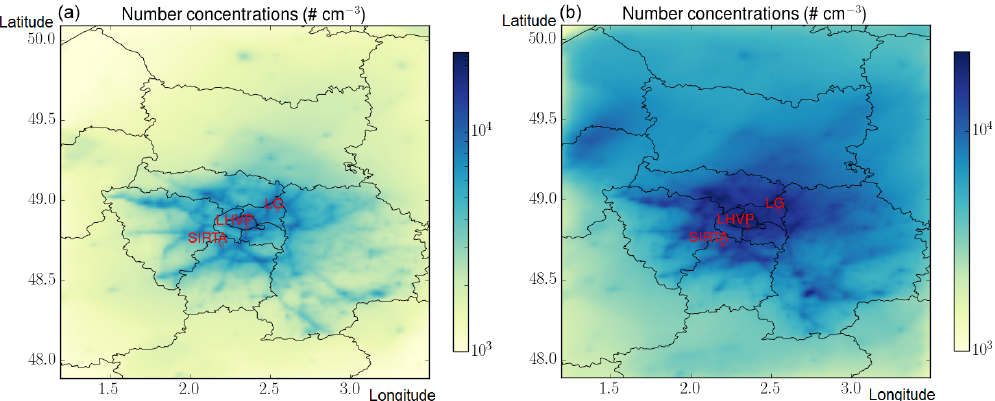
Figure 4. Number concentrations (in cm − 3 ) for the simulation without nucleation (a) and the simulation with heteromolecular nucleation (b) .